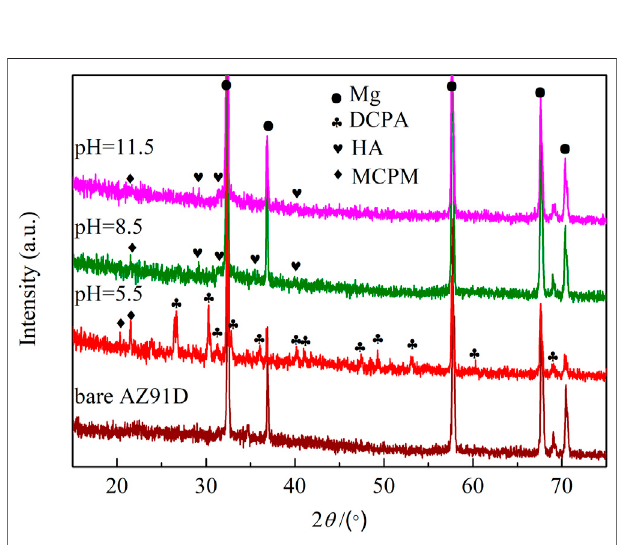
FIGURE 10 | EDX results of the areas marked in Figure 9 : (A) EDX spectra, (B) Ca/P atomic ratio.